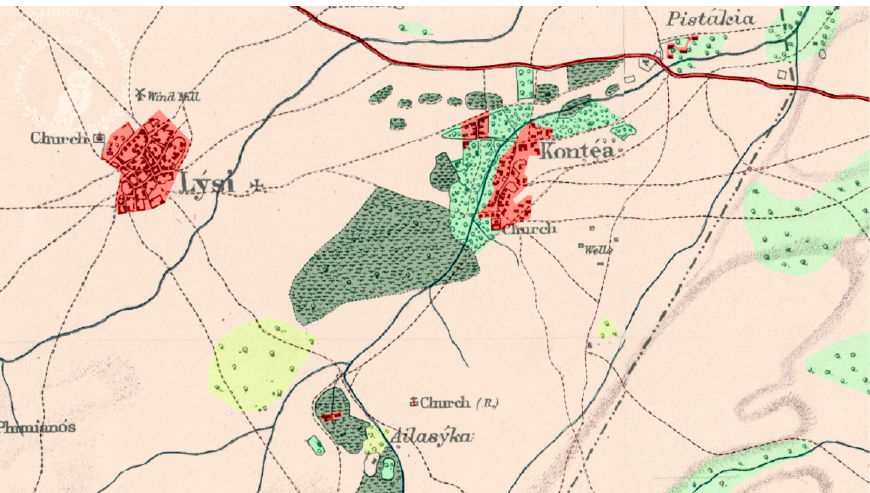
Figure 4. Various geospatial entities in the central plain of the island colored according to GIS layers: red polygons—settlements, green polygons—vineyards, pale green polygons—agricultural land, red lines—roads, blue lines—streams. Wells, ruins, windmills, and churches are also visible.